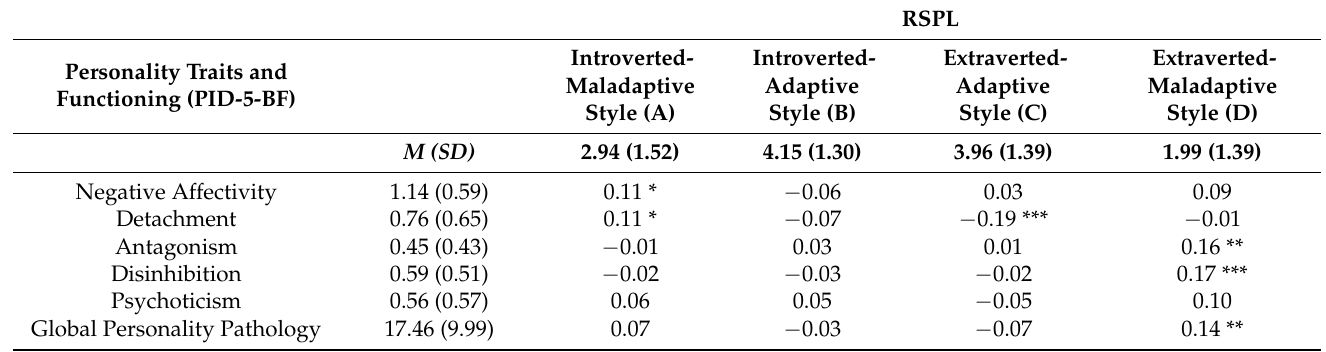
Table 2. Bivariate Correlations Between Response Styles to the COVID-19 Pandemic and